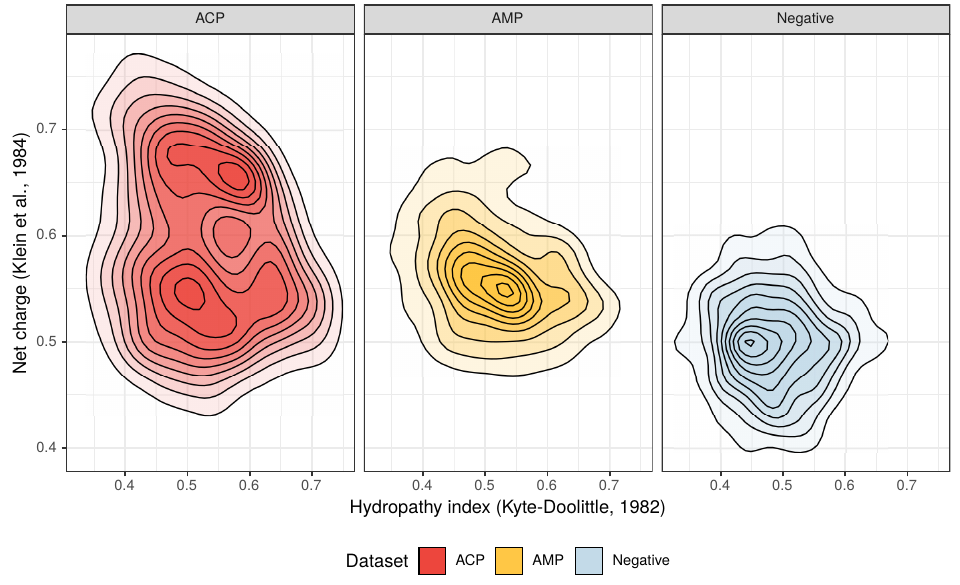
Figure 2. Distribution of the hydropathy index and net charge for anticancer peptides (ACPs), antimicrobial peptides (AMPs) and non-ACP/non-AMP sequences (Negative).